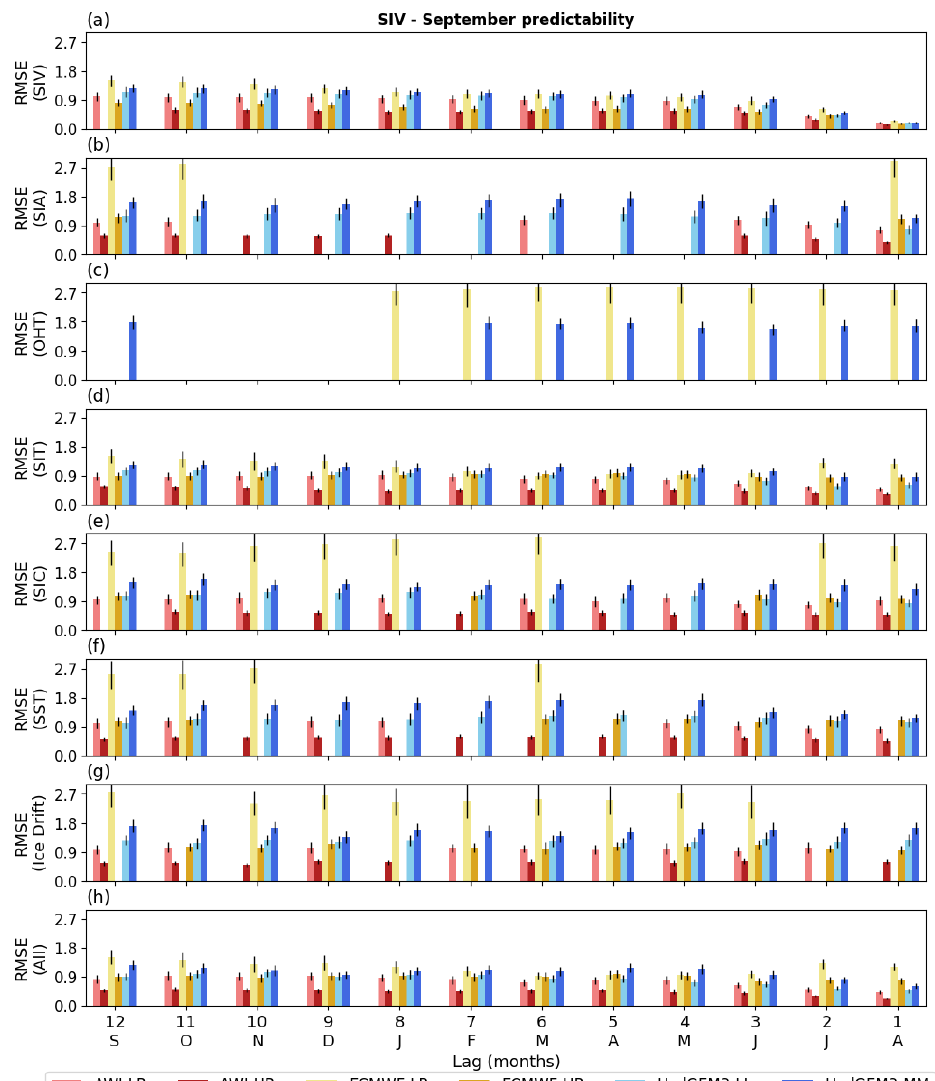
Figure 5. Statistical predictability of the September SIV anomalies, estimated from 12 leading months and quantified by the RMSE (10 3 km 3 ) calculated between the original and reconstructed time series (Sc), as prescribed by seven predictors: (a) SIV itself, (b) SIA, (c) OHT, (d) SIT, (e) SIC, (f) SST, (g) Drift. The predictions employing all predictor variables (except the SIV itself) are displayed in (h) . The vertical black lines indicate the error as provided by the 500 Monte Carlo simulations. The statistical predictability follows the methodology introduced in Sect. 2.3. Missing vertical bars mean that the statistical reconstruction is not statistically significant. The long-term trend and seasonal cycle are excluded from both predictand and